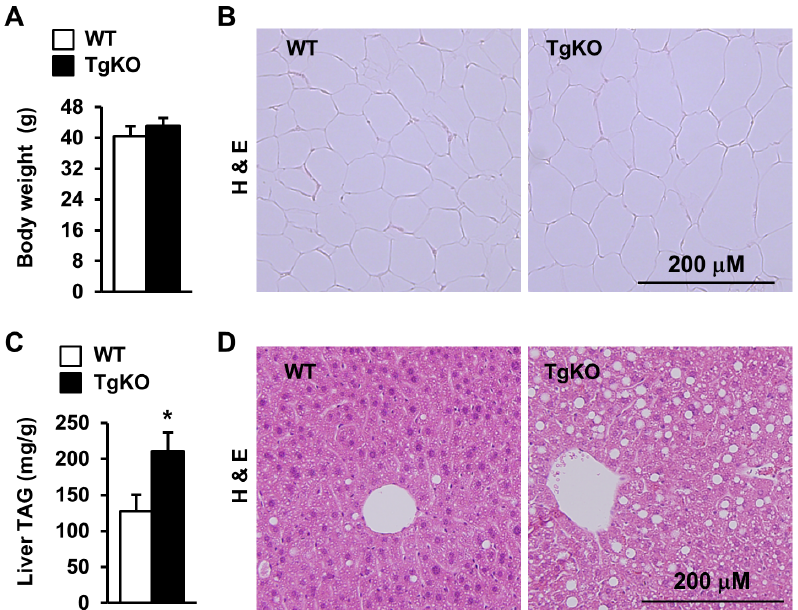
Figure 1. Deletion of SH2B1 in peripheral tissues augments HFD-induced hepatic steatosis. Male mice (7 weeks of age) were fed a HFD for 16 weeks. (A) Fasting body weight. WT: n=9, TgKO: n=7. (B) A representative H & E staining of epididymal fat depots. (C) Liver TAG levels (normalized to liver weight). WT: n=6; TgKO: n=6. (D) A representative H & E staining of liver sections. Data are presented as means 6 SEM. P , 0.05.